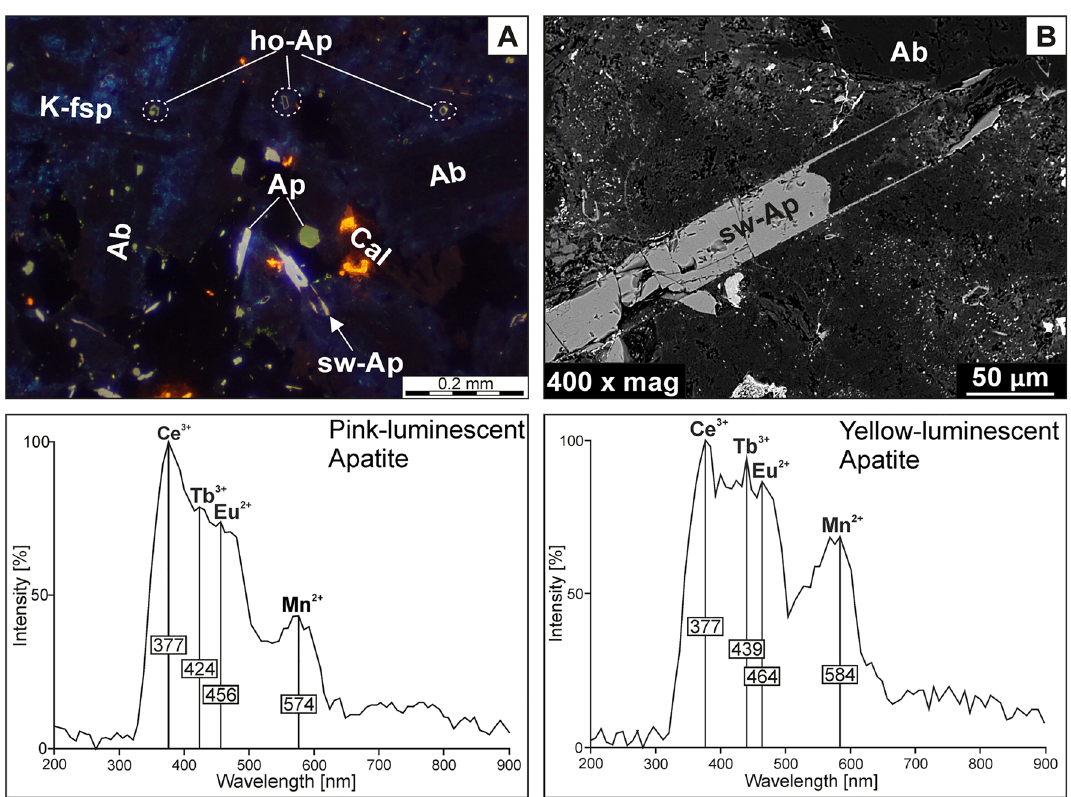
Figure 8. ( A ) Two-types of fluorapatite species showing pinkish and yellowish CL colours depending on size and orientation of particular crystals (Loc. 1); Note the occurrence of hollow-type (ho-Ap) and swallow-tail (sw- Ap) fabrics. ( B ) BSE image of fluorapatite (embedded within the cryptocrystalline groundmass) showing well- developed swallow-tail morphology (Loc. 2). Note the CL spectra of pink-luminescent and yellow-luminescent fluorapatite in the spectra range 200–900 nm were included at the bottom of the